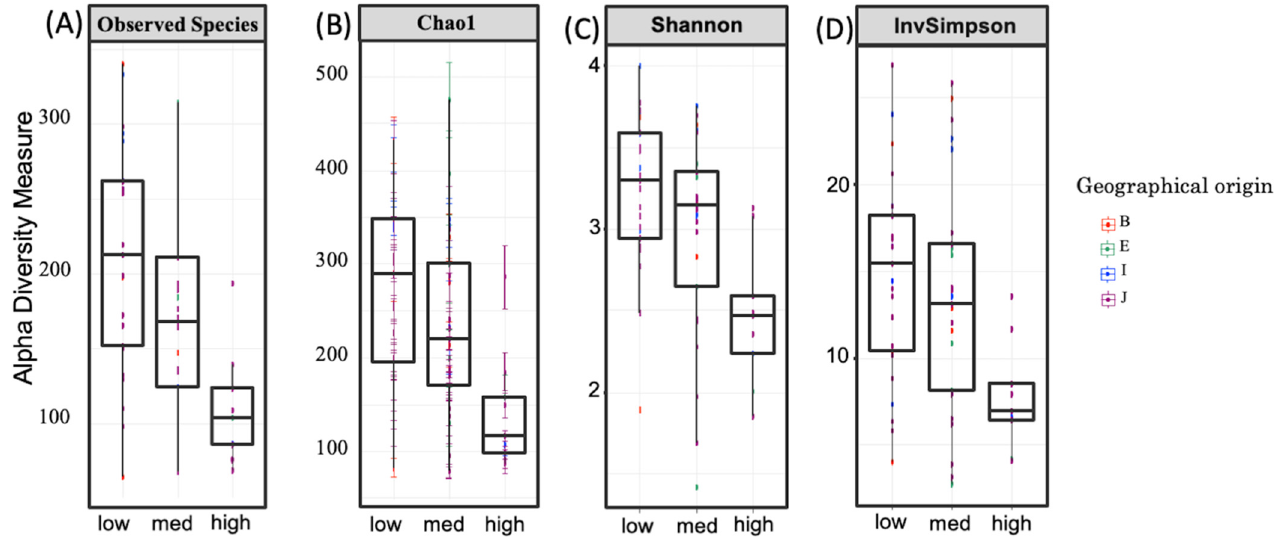
Figure 2. Alpha diversity among fecal GABA groups. Alpha diversity, measured by observed species ( A ) and Chao1 ( B ), Shannon diversity ( C ), and inverse Simpson indices ( D ), is plotted for examined samples, i.e., in high-, medium-, and low-GABA groups. Box plots depict microbiome diversity and abundance differences according to each test. The horizontal line inside the box represents the median. Outliers and individual sample values are represented by dots. Different colors represent the geographical origin of each participant: B, South Asia; E, Northeast Africa; I, Southeast Asia; J, East Asia. All alpha diversity measurements shown here significantly decreased in the high-GABA group compared to those in the low group.